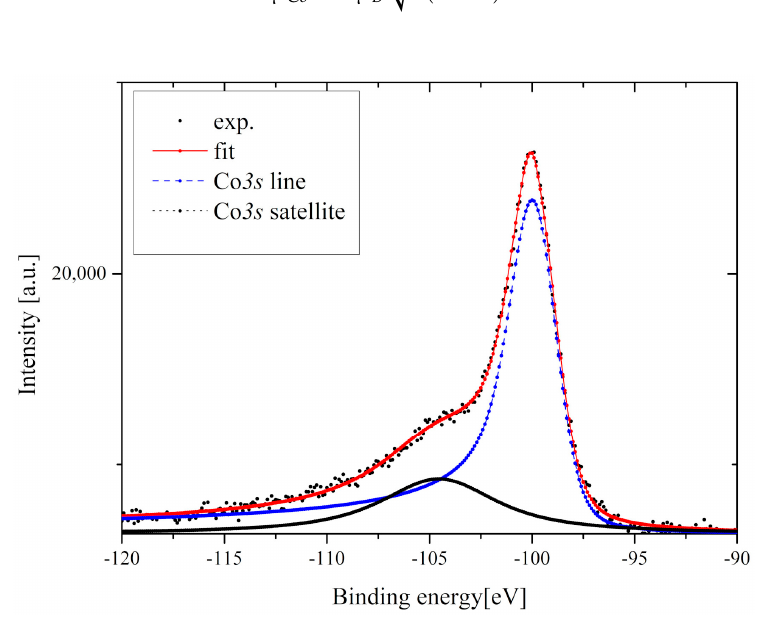
Figure 11. The Co 3s multiplet splitting for the Gd 0.4 Tb 0.6 Co 2 .